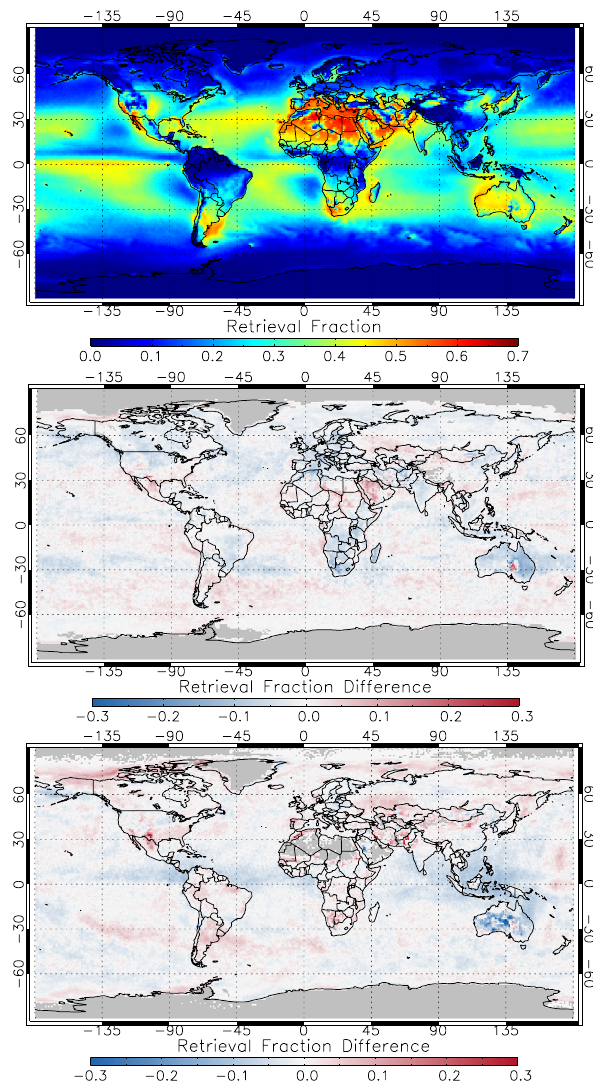
Fig. 10. (Top) 13 yr averaged retrieval fraction of SeaWiFS AOD from 1997 to 2010 and (middle) the differences in SeaWiFS re- trieval fraction between early years (2000–2003) and later years (2007–2010). For comparison, the differences in Terra/MODIS re- trieval fraction between the same two periods are also shown (bot-